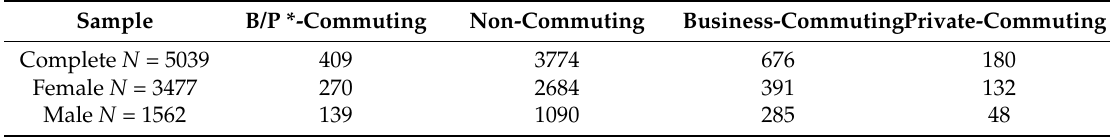
Table 3. Sample sizes depending on commuting status and gender.